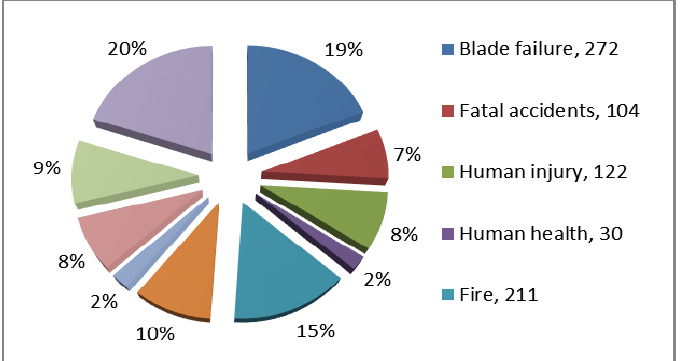
Figure 2. Distribution of wind power generator damage